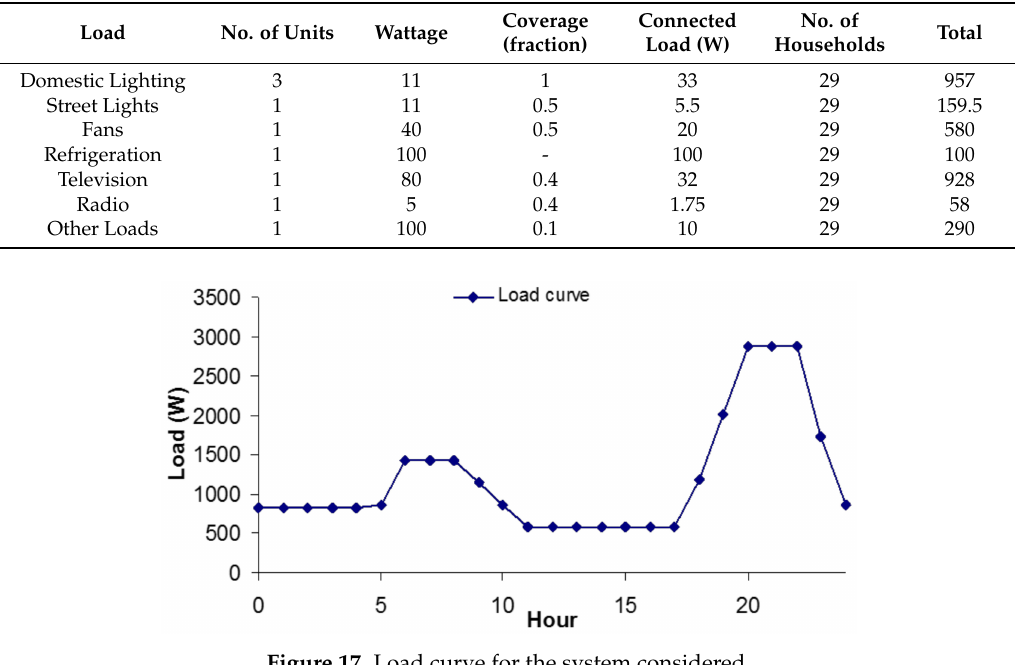
Figure 17. Load curve for the system